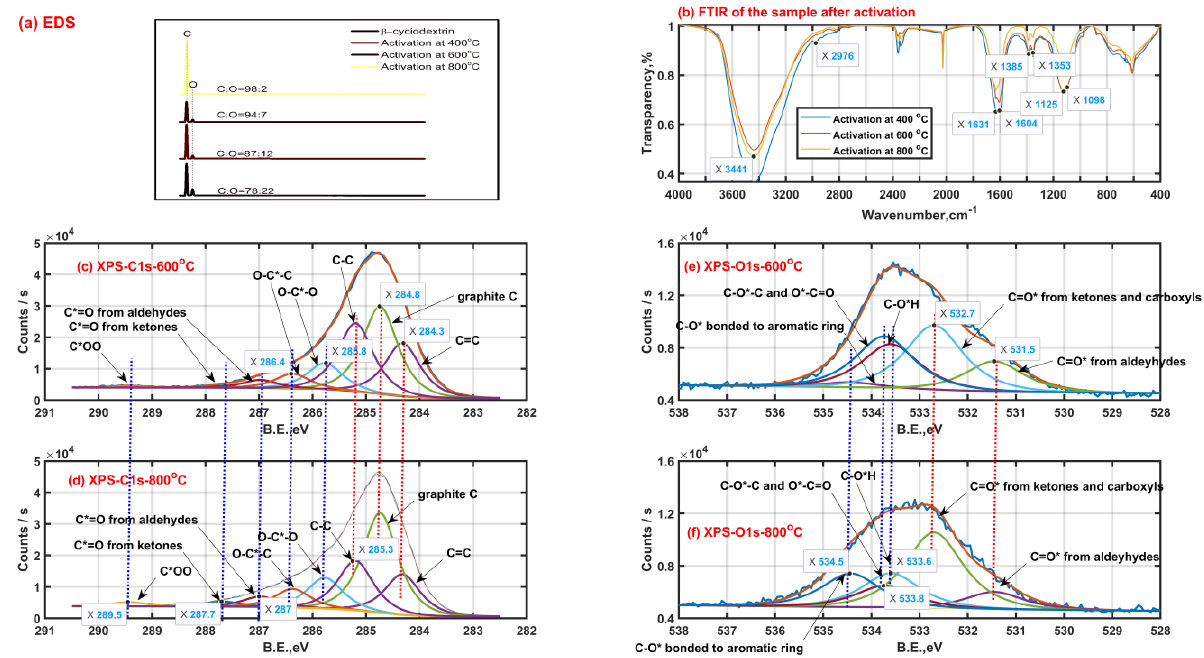
Figure 3. Solid product characteristics with a heating rate of 5 °C/min (EDS Energy dispersive spec- troscopy ( a ); Fourier transform infrared spectra ( b ); X-ray photoelectron spectra of carbon (( c ) - 600 °C, ( d )-800 °C) and oxygen (( e )-600 °C, ( f )-800 °C)).